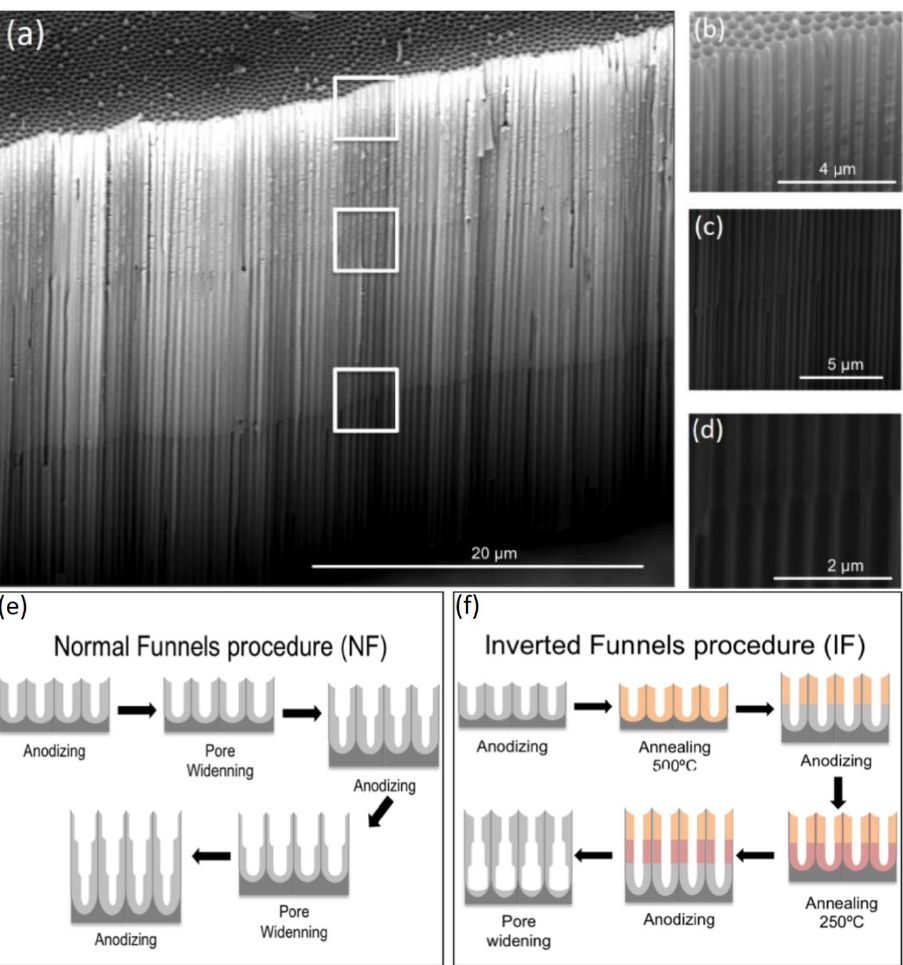
Figure 11. Cross-section ESEM images of inverted funnel NAA structure and fabrication schematics. ( a ) Entire structure, ( b – d ) magnified images of transitional regions, ( e ) fabrication procedure of funnel morphology, and ( f ) inverted funnels morphology. Reprinted (adapted) with permission from [175]. Copyright 2017 MDPI.